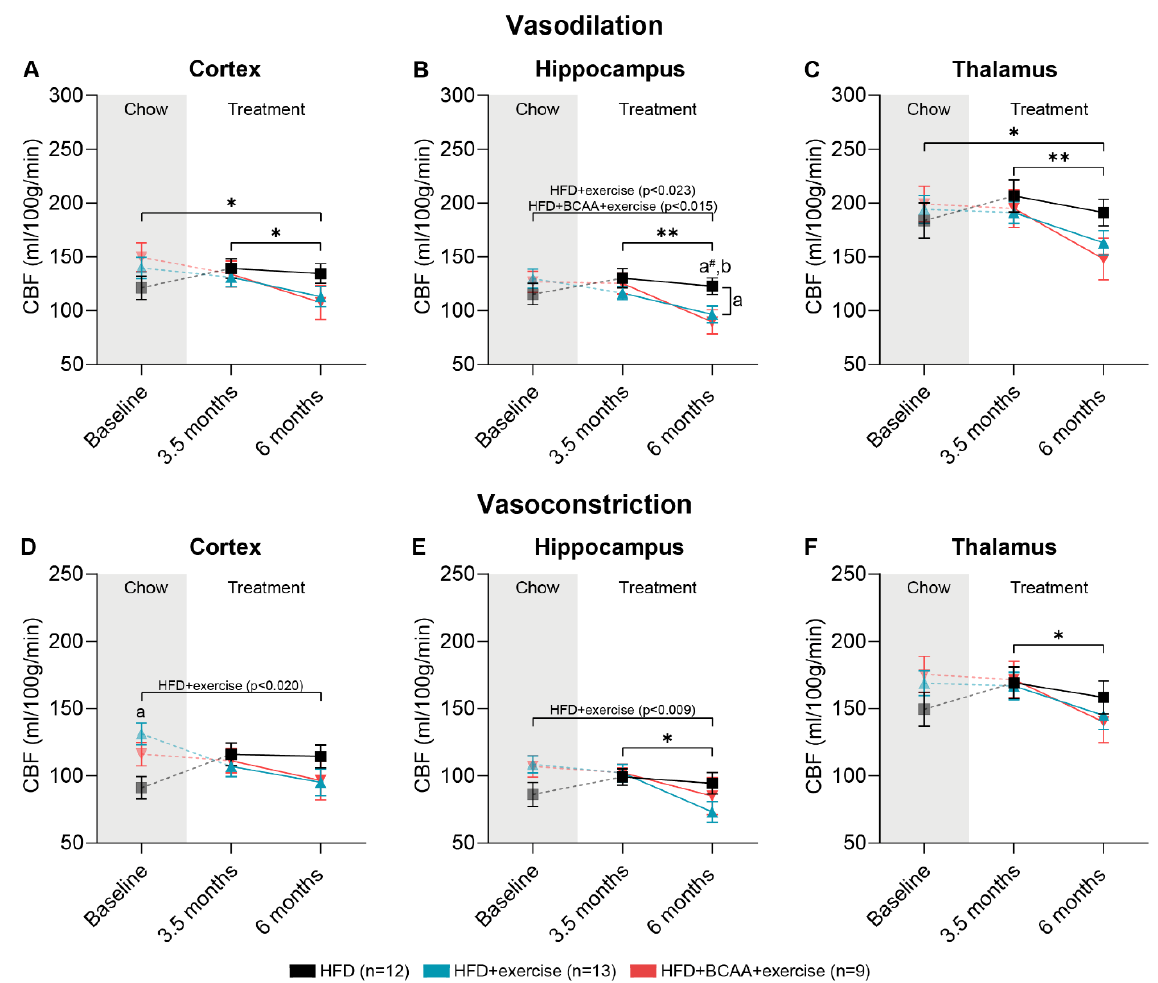
Figure 8. Measurement of cerebral blood flow under vasodilative and vasoconstrictive conditions. Cerebral blood flow (CBF) was measured by arterial spin labeling at baseline (chow) and after 3.5 and 6 months of treatment with HFD, HFD + exercise, and HFD + BCAA + exercise. At each neuroimaging session, CBF was first assessed under vasodilative conditions in the ( A ) cortex, ( B ) hippocampus, and ( C ) thalamus, and afterwards under vasoconstrictive conditions in the ( D ) cortex, ( E ) hippocampus, and ( F ) thalamus. High-fat diet (HFD), branched-chain amino acids (BCAA), cerebral blood flow (CBF). Data are presented as mean ± SEM. * p < 0.05, ** p < 0.01, # 0.05 < p < 0.08 (trend); a: significant difference HFD vs. HFD + exercise group, b: significant difference HFD vs. HFD + BCAA + exercise group.